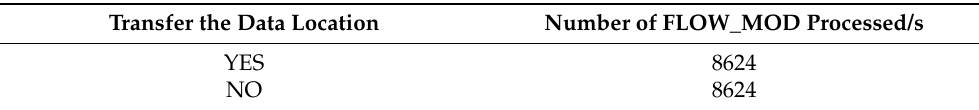
Table 7. The impact of the conversion data location on the FLOW_MOD message loading